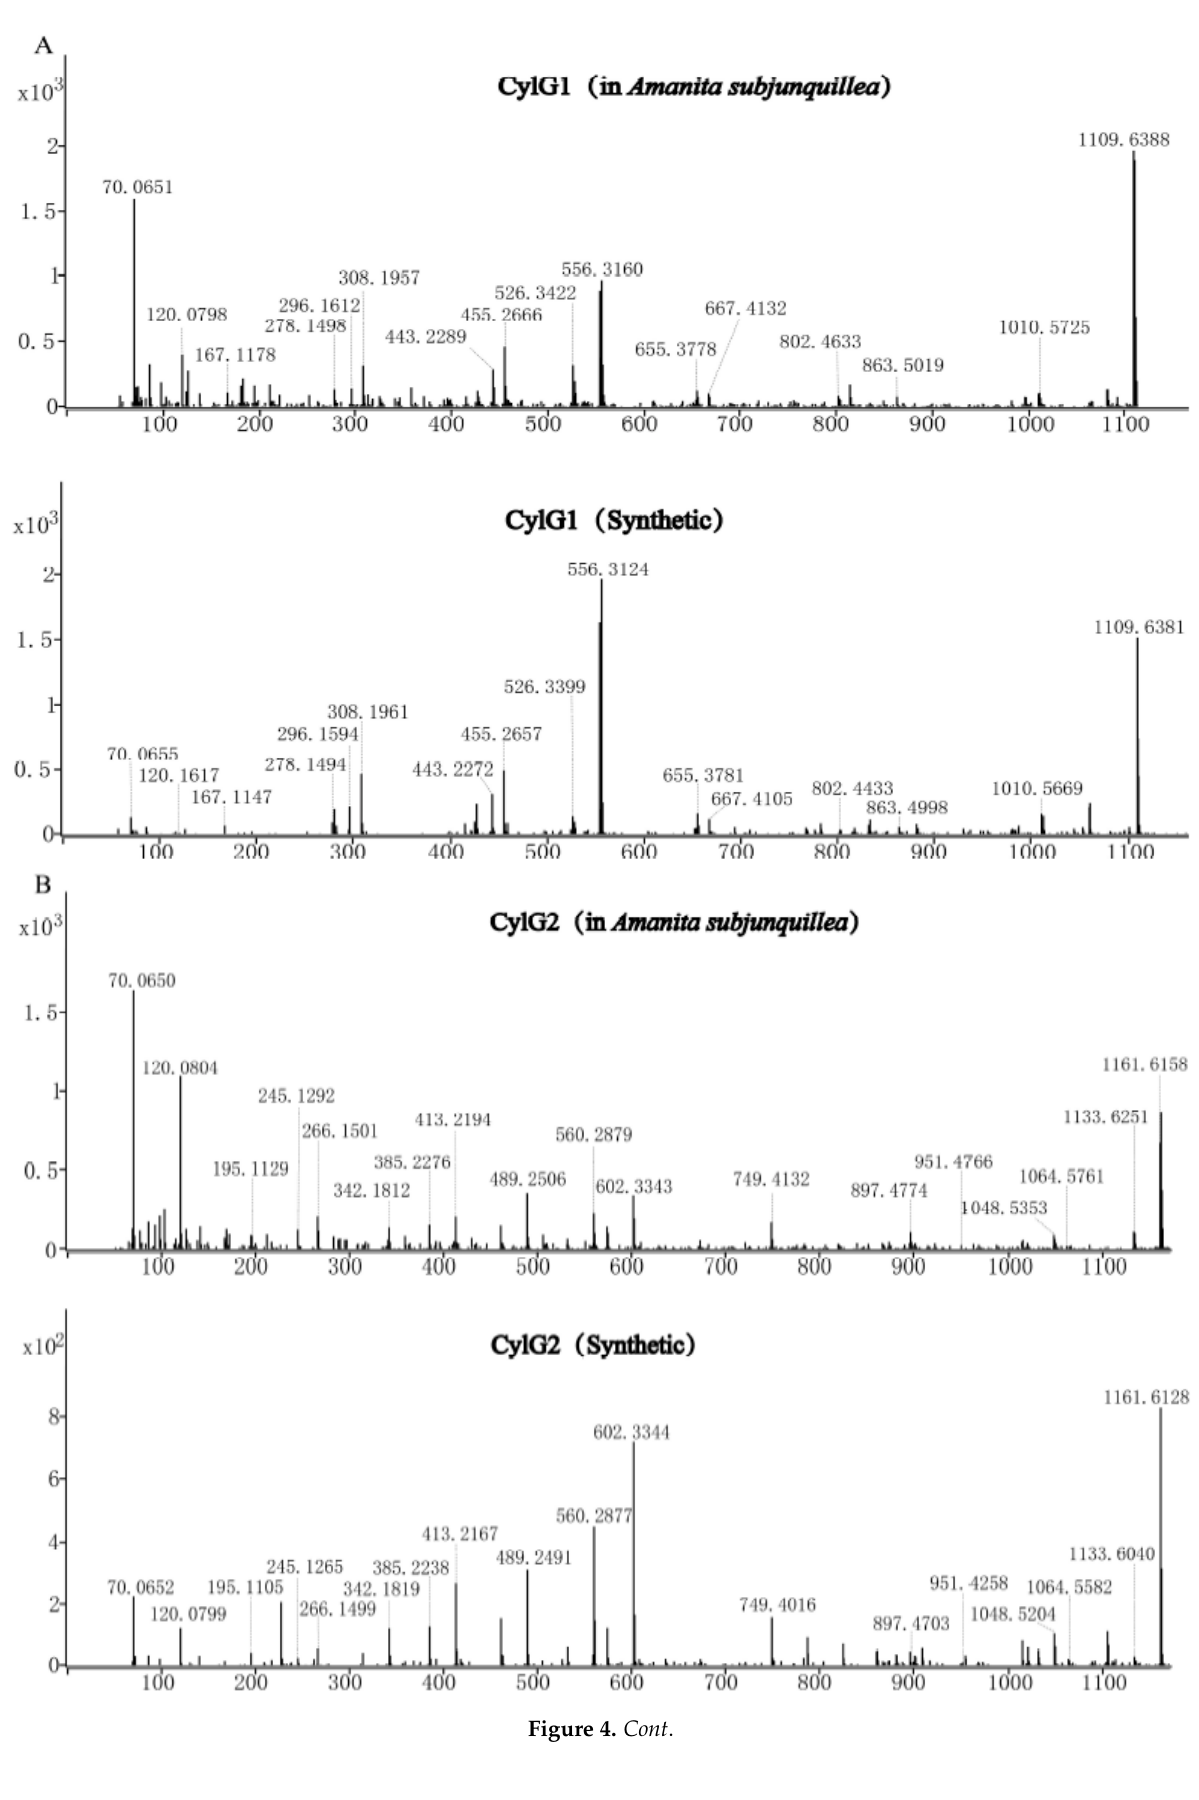
Figure 4. MS/MS fragment comparison of three natural and synthetic cyclic peptides from Amanita species. Fragment ions of natural and synthetic CylG1 ( A ), CylG2 ( B ), and amanexitide ( C ). CylG1 and CylG2 are produced by A. subjunquillea , and amanexitide is produced by A. exitialis . Shared ions are labeled.